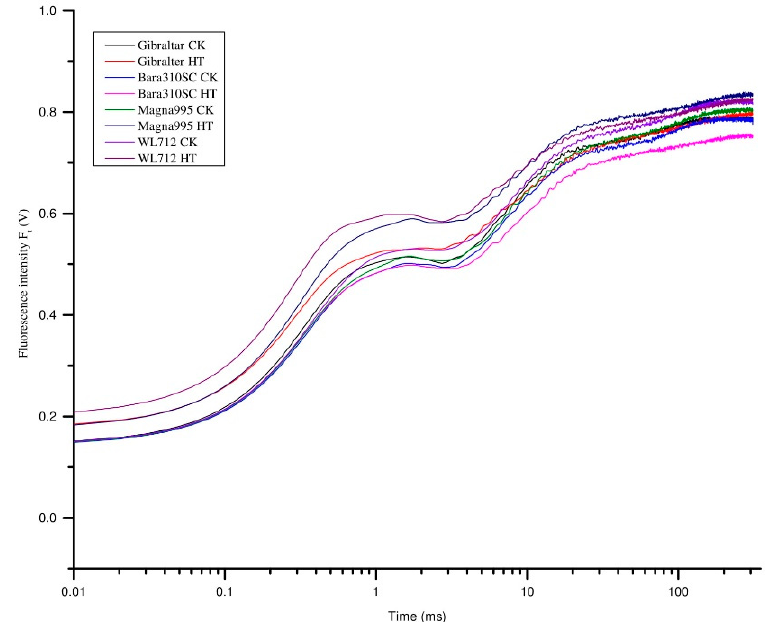
Figure 4. Effect of heat stress on the chlorophyll a fluorescence transient (OJIP curves) of 4 alfalfa cultivars after seven days of heat treatment. CK represents control treatment and HT represents heat treatment ( n = 5).